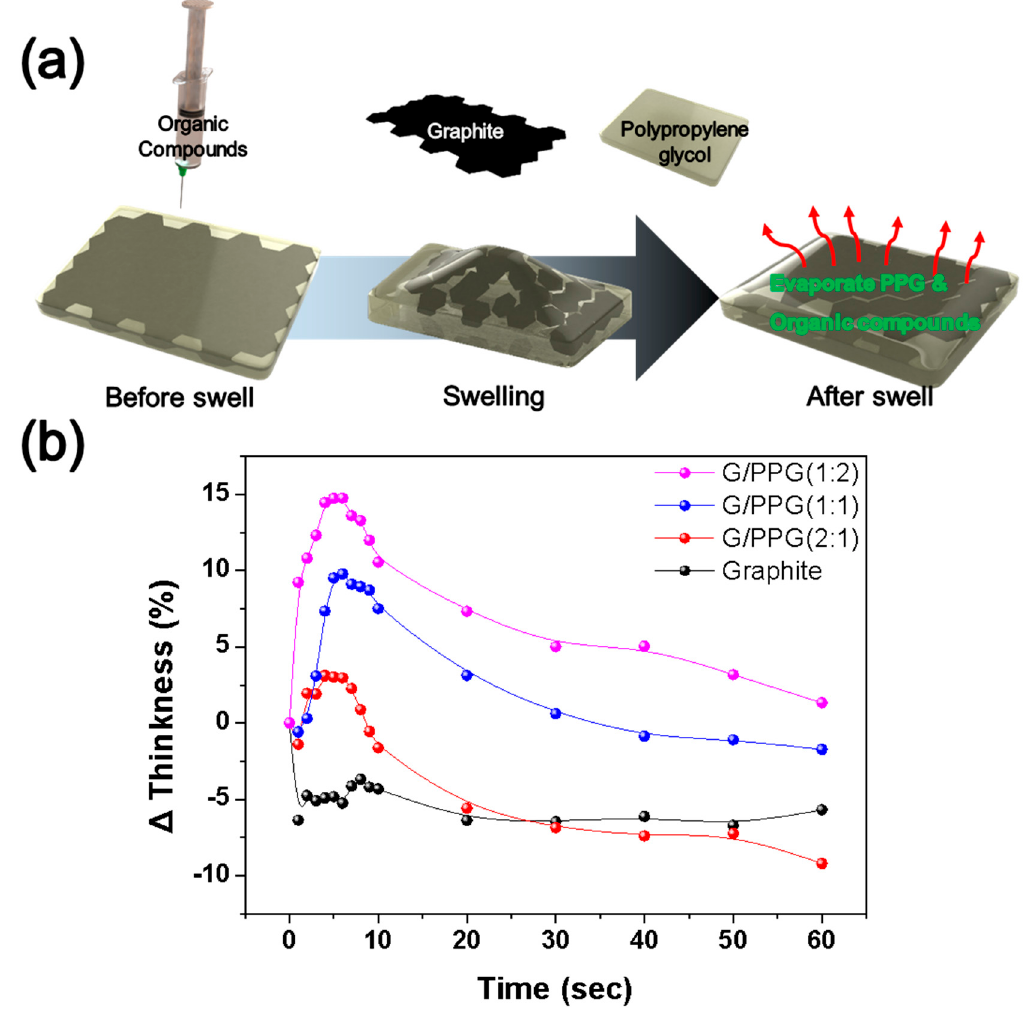
Figure 2. Swelling mechanism of G / PPG HC sensor films. ( a ) Sensor operating mechanism and ( b ) thickness variation of films at gasoline.